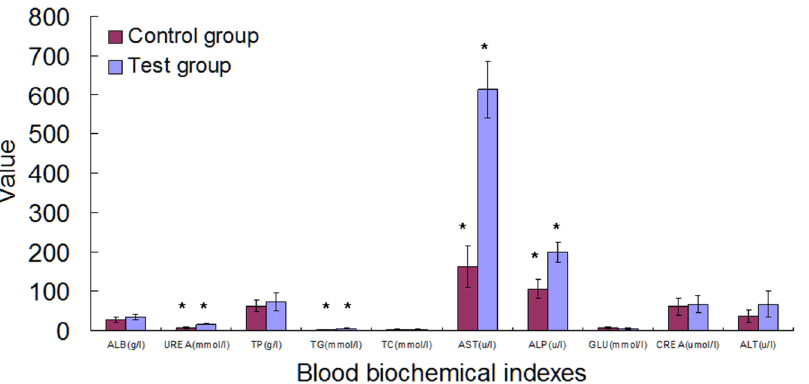
Figure 3. Effect of Cry1Ab protein on the blood biochemistry in Swiss rat that feeding for 30 days. The blood biochemistry indexes including ALB, UREA, TP, TG, TC, AST, ALP, GLU, CREA and ALT were assayed. The red bar represents the control group and the blue bar represents the test group.